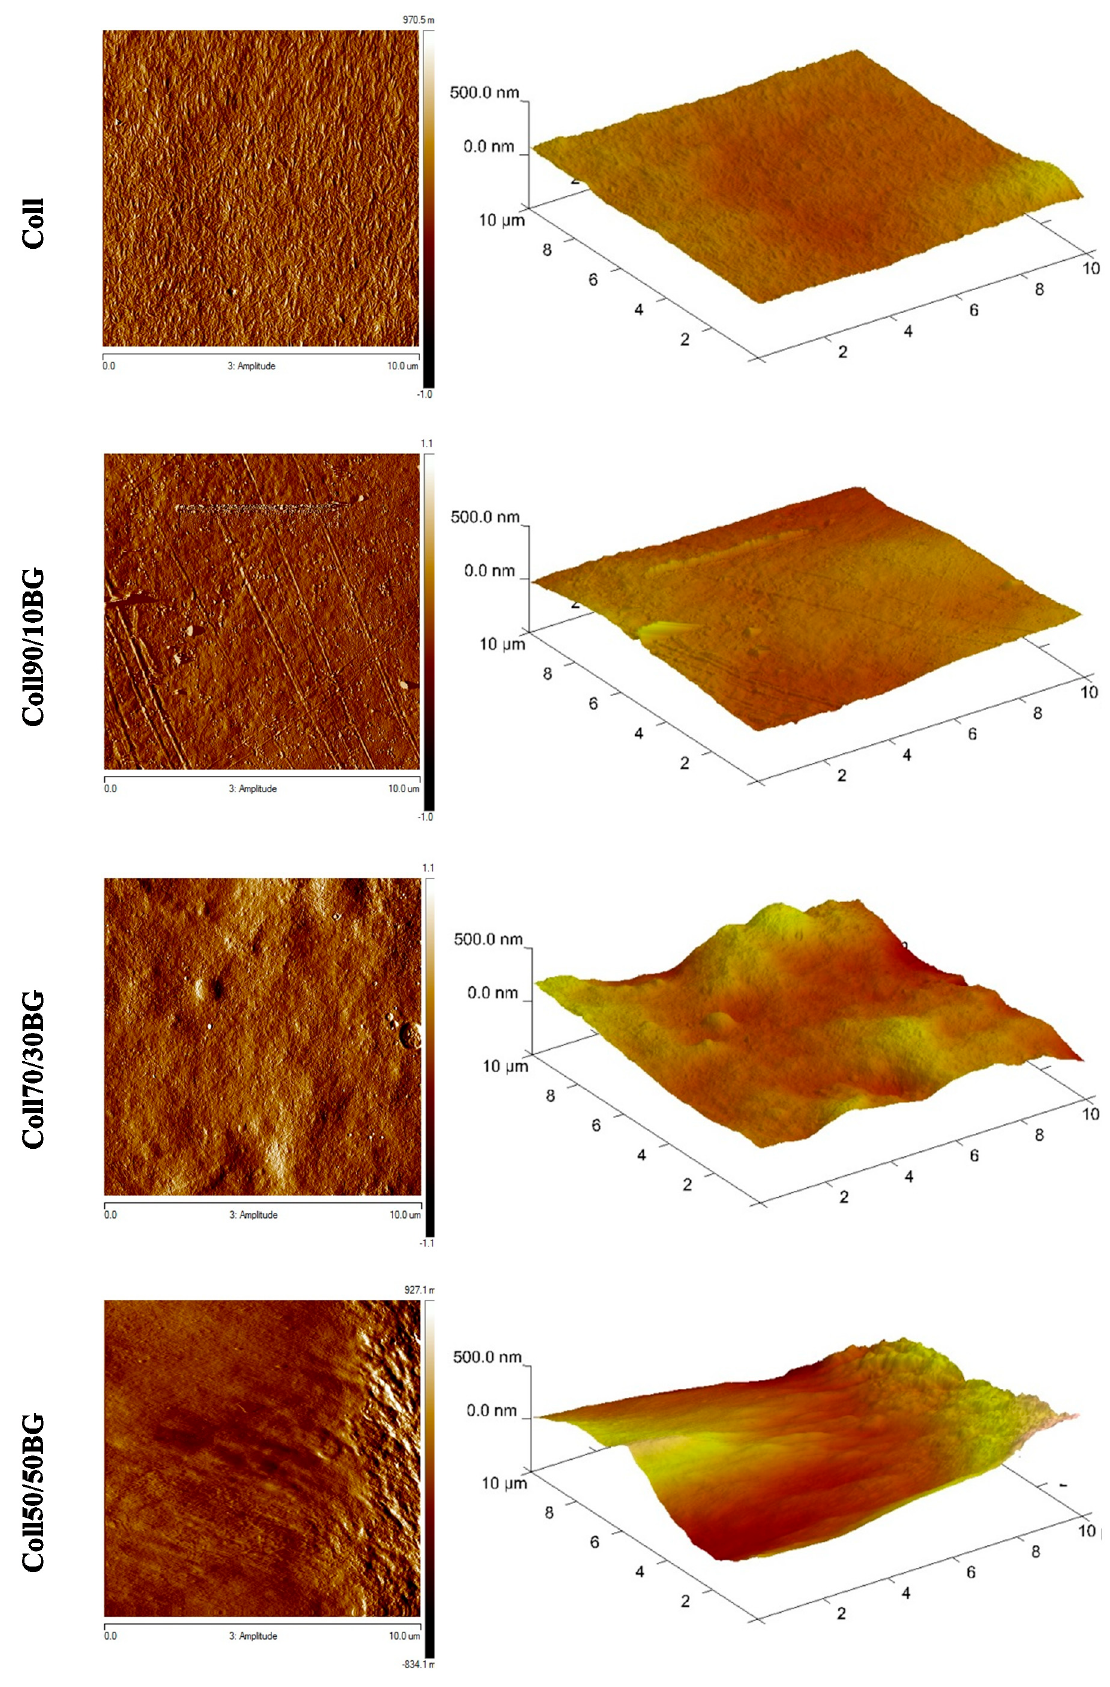
Figure 3. Pictures of structure morphology of collagen and collagen/ β -glucan films.